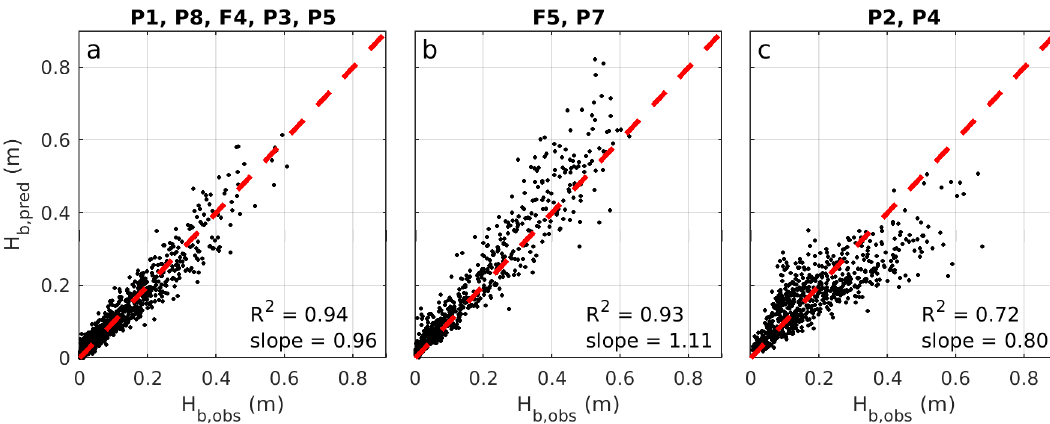
Figure 5. Predicted bound wave height as a function of the observed bound wave height at the shelf (panel a : P1, P8, F4, P3, and P5), the seaward slope (panel b : F5 and P7), and the ebb-tidal shoal (panel c : P2 and P4). The red dashed line has slope